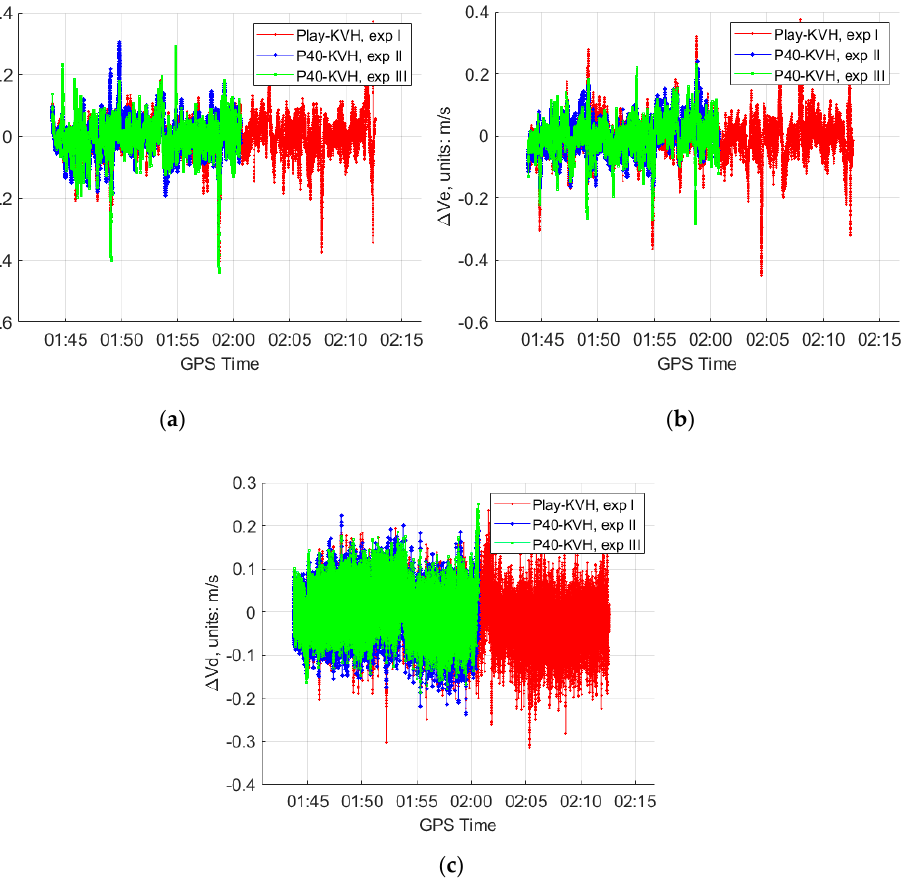
Figure 6. The velocity differences of the GNSS/IMU coupled solutions between the two smartphones (our program in a 15-state Kalman filter) and the ‘‘KVH 1750” (IE software) in GNSS open-sky condition at experiment I, II and III. ( a ) Velocity differences in the North direction; ( b ) velocity differences in the East direction; ( c ) velocity differences in the Down direction.